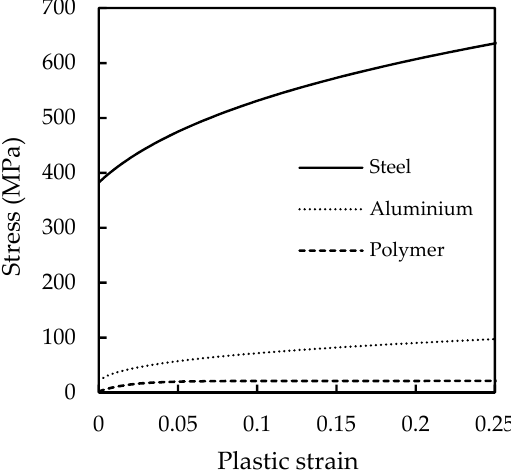
Figure 1. Hardening curves of the metallic outer layers and polymer core.